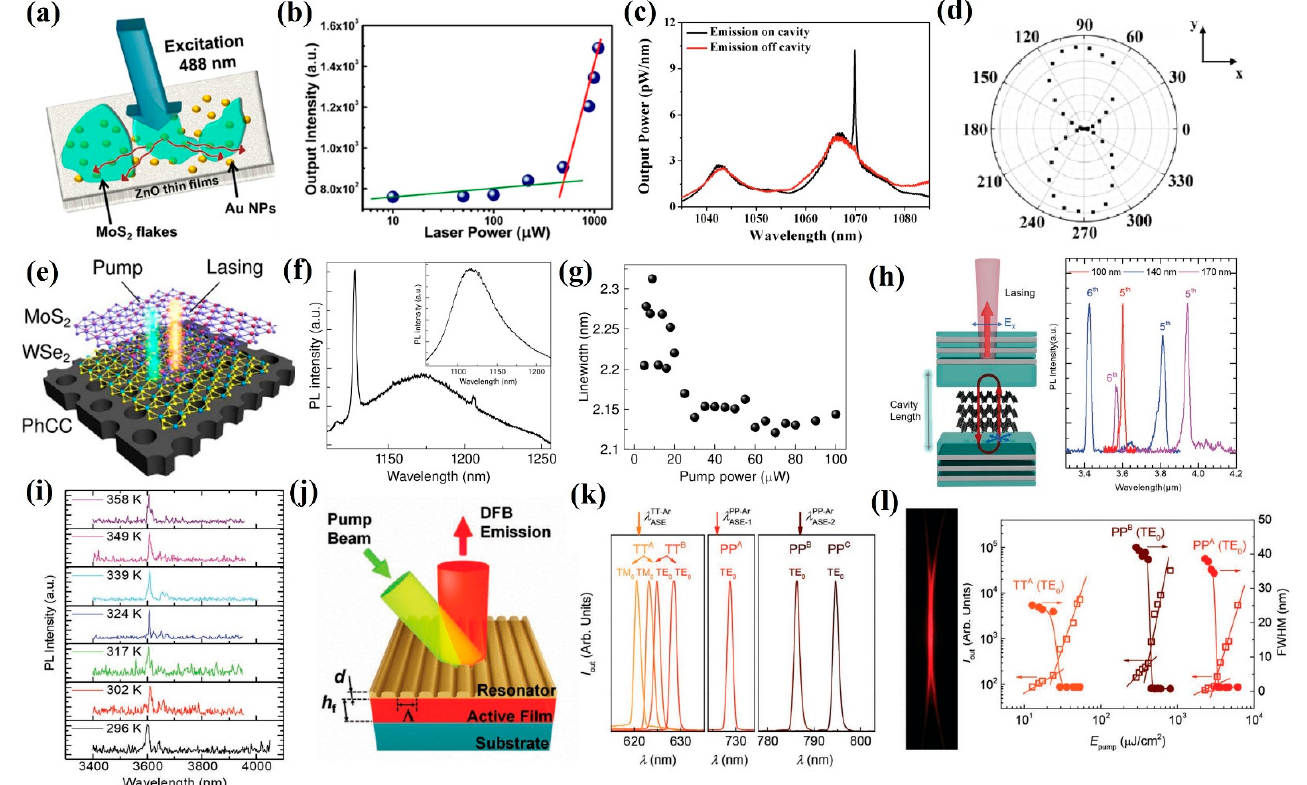
Figure 5. Laser based on 2D materials. ( a ) Schematic diagram of the MoS 2 -based laser device. ( b ) The lasing threshold of the multilayer MoS 2 -based device. ( c ) The measured laser emission of the MoTe 2 -based device with and without cavity. ( d ) The polarization-dependent measurement of the laser emission. ( e ) Schematic diagram of the MoS 2 -/WSe 2 -heterostructure-based device. ( f ) The measured laser emission of the WSe 2 and MoS 2 heterostructures with nanocavity. Inset: the laser emission without nanocavity. ( g ) The line width of the laser as a function of pump power. ( h ) Schematic diagram of the BP-based laser device and the measured laser emission of various BP thicknesses. ( i ) The laser emission temperature-dependent measurement of the device with a 140 nm thick BP. ( j ) Schematic diagram of the nanographene-based DFB laser device. ( k ) The measured laser emission of the device. ( l ) The optical image of the laser beam of the device and the intensity, with line width of the laser emission as a function of pump energy density. Reprinted with permission from ( a , b ) Reprinted from [146], with permission from American Chemical Society, 2018; ( c , d ) Reprinted from [147], with permission from The Korean Physical Society, 2018; ( e – g ) Reprinted from [148], with permission from American Association for the Advancement of Science, 2019; ( h , i ) Reprinted from [149], with permission from Wiley-VCH, 2020; ( j – l ) Reprinted from [150], with permission from Wiley-VCH, 2021.